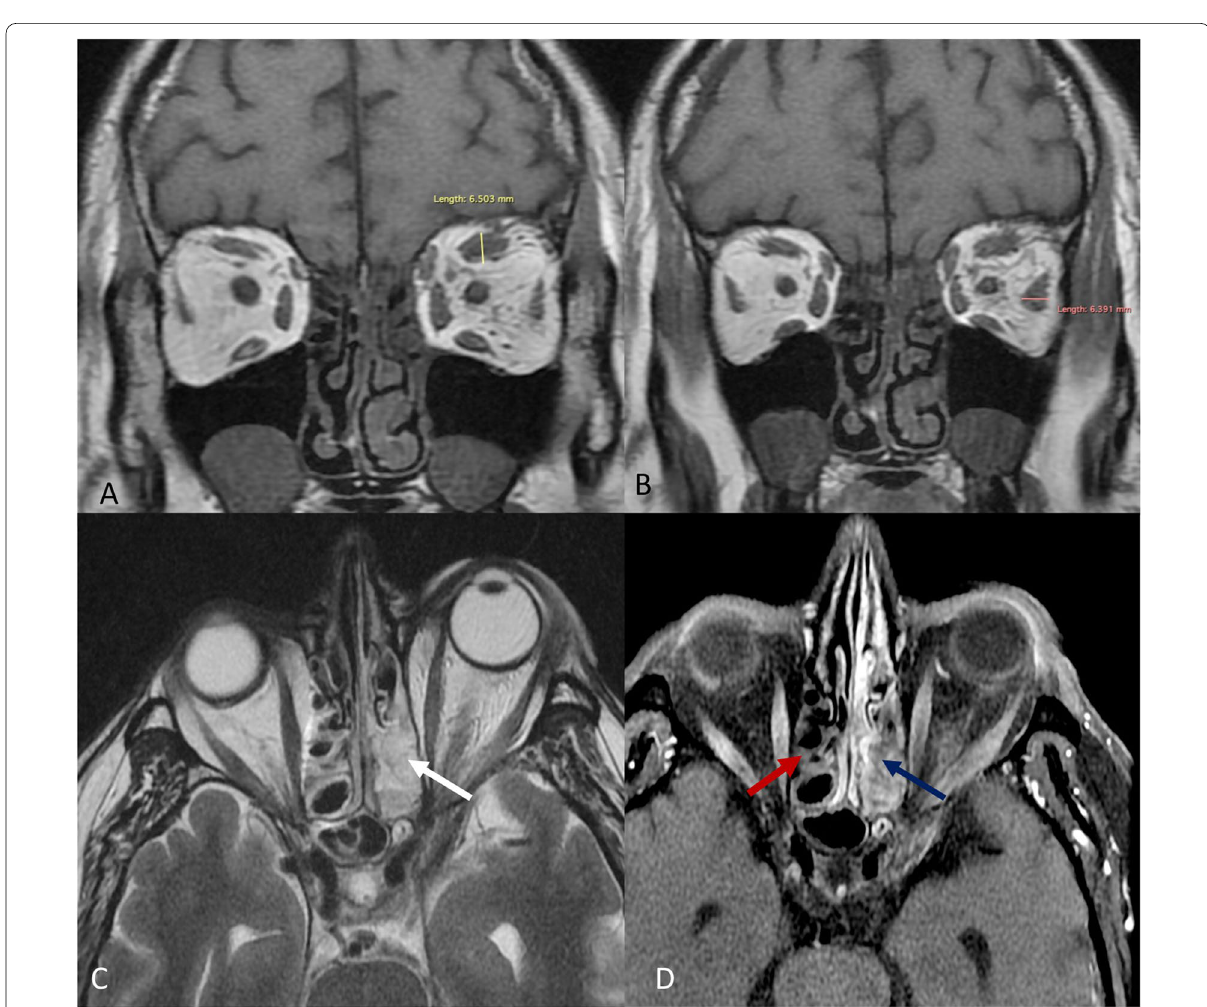
Fig. 5 T1W coronal images ( A , B ) show bulky superior rectus, lateral rectus and superior oblique muscles and intraconal fat stranding along with bulky middle and inferior turbinates. Polypoidal mucosal thickening is also seen in both maxillary sinuses. C T2W axial image shows proptosis of left orbit with preseptal swelling along with mucosal hypertrophy and T2 hyperintense contents in ethmoid sinus predominantly on left side (white arrow). D T1 post contrast axial image shows contiguous non-enhancing areas involving the walls of ethmoid sinus and middle turbinate on left side- black turbinate sign (blue arrow). Walls of right ethmoid sinus show lack of enhancement (red